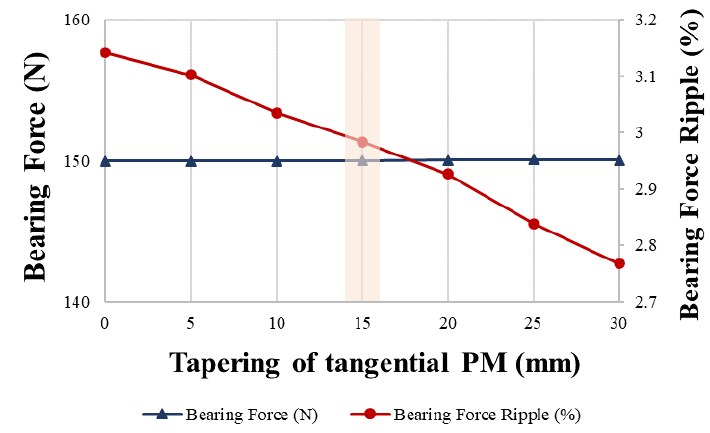
Figure 23. Bearing force and ripple according to tapering of tangential PM.